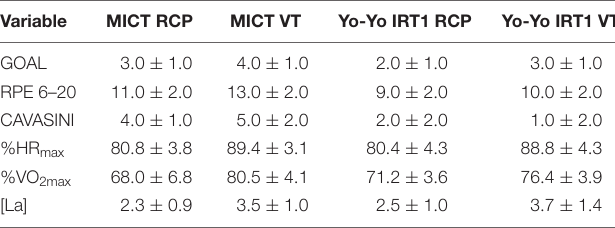
TABLE 2 | Ventilatory threshold and respiratory compensation point and their corresponding variables. Variable